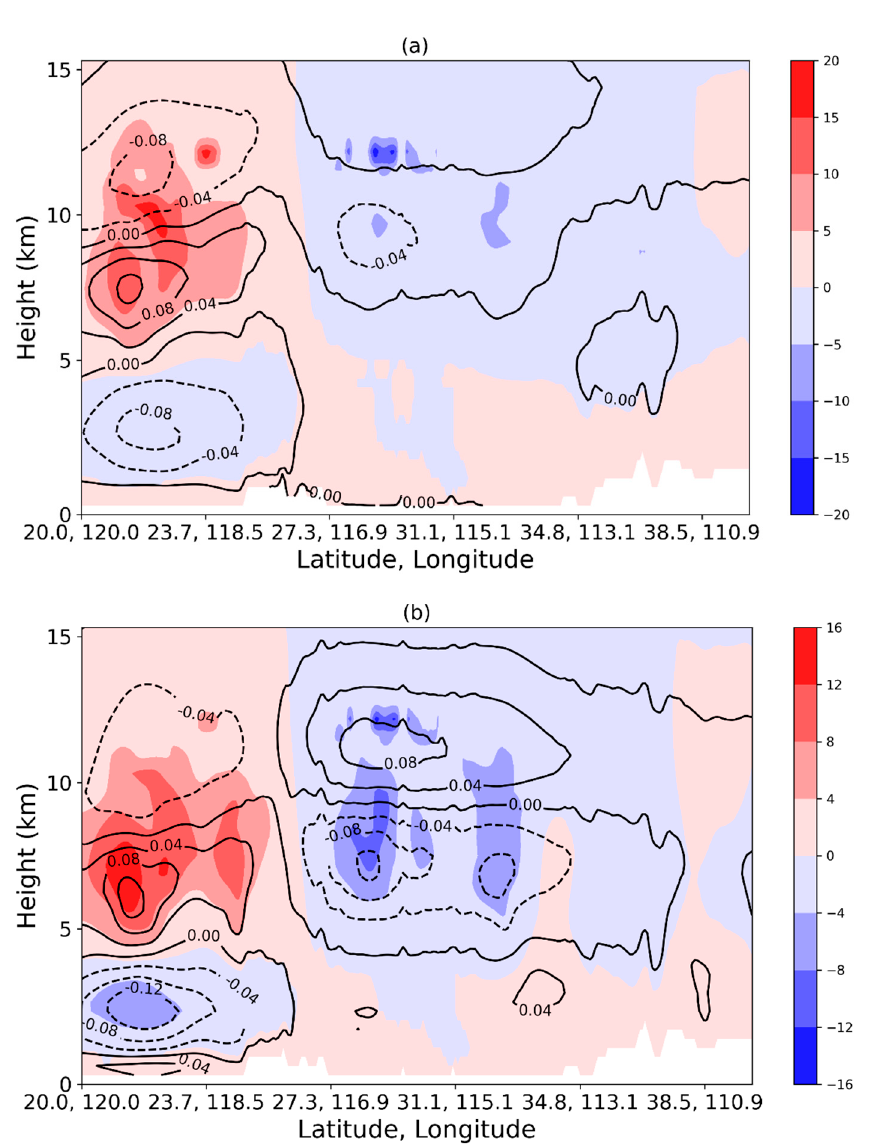
Figure 9. Cross-sections along with line AB of the relative humidity (shaded, units: %) and tem- peratures (black curves, units: K) for ( a ) EXP_WV9-CTL and ( b ) EXP_WV10-CTL at 0000 UTC on 5